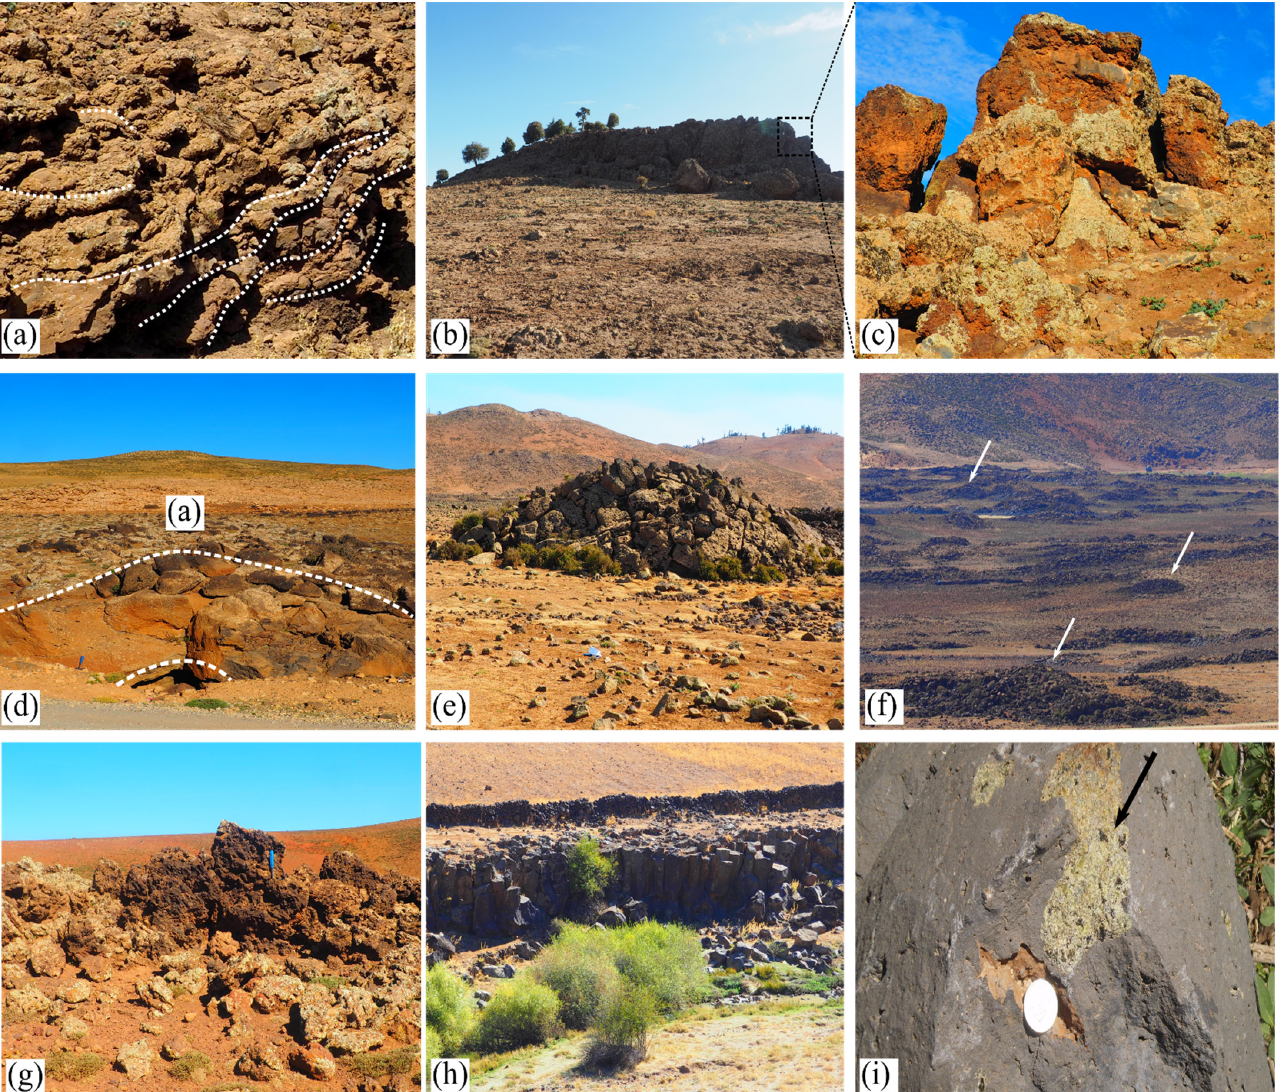
Figure 12. ( a ) The second effusive phase basaltic flow (Pahoehoe ) of Timahdite volcano; ( b ) and ( c ) The lava flow ‘a ā emitted by the Ta’issaouit volcano; ( d ) Tumulus structure found in the southwestern part of Aguelmam Sidi Ali volcano; ( e ) Hornitos structure found in the southwestern part of Aguelmam Sidi Ali volcano; ( f ) The flood basalt of Aguelmam sidi Ali volcano flood basalt, shows several hornitos structures in the southwestern part; ( g ) clastogenic dykes observed in the northern part of Aguelmam sidi Ali volcano; ( h ) the basalt organ outcropping in the Oued Guigou valley; ( i ) blocky lava flow containing olivine xenoliths in the southern part of Lachmine N’kettane volcano.